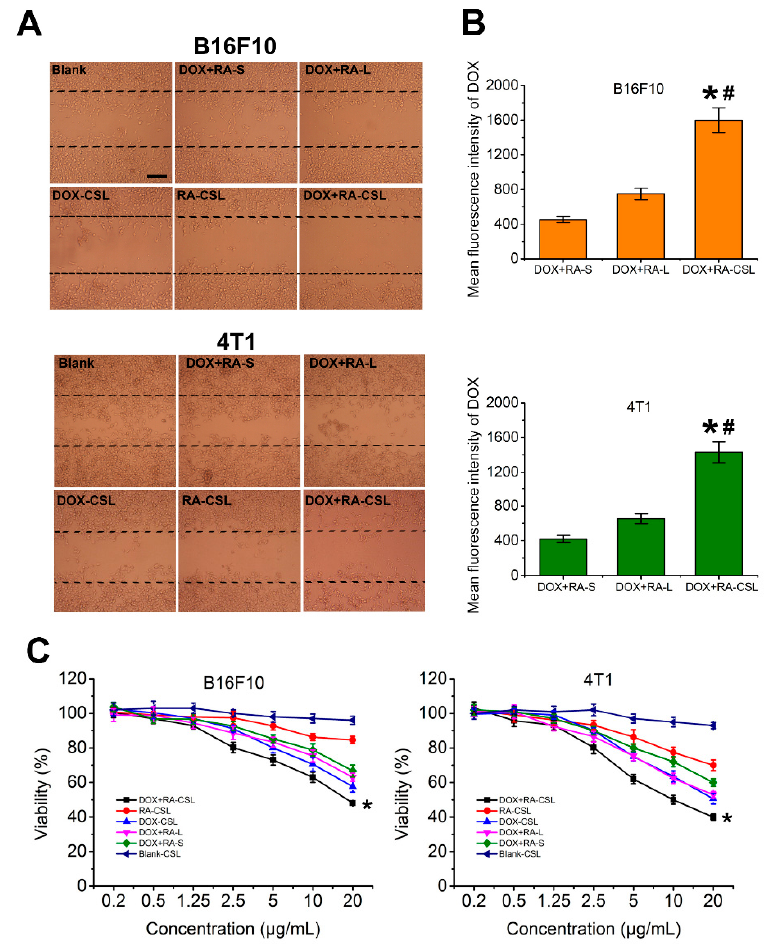
Figure 2. In vitro evaluation of DOX+RA-CSLs. ( A ) inhibition of B16F10 and 4T1 cell migration after treatment with various formulations for 24 h, Bar, 50 µ m; ( B ) mean fluorescence intensity of DOX in DOX+RA-S-, DOX+RA-L-, and DOX+RA-CSL-treated B16F10 and 4T1 cells. Data are expressed as mean ± SD ( n = 3). * p < 0.05 versus DOX+RA-S group, # p < 0.05 versus DOX+RA-L group; ( C ) cytotoxicity of drug-free and drug-loaded liposomes toward B16F10 and 4TI cancer cells after incubation for 12 h. Data are expressed as mean ± SD ( n = 3). * p < 0.05 vs. Blank CSL group. CSLs: chondroitin sulfate liposomes; RA-CSLs: retinoic acid-loaded CSLs; DOX-CSLs: doxorubicin- loaded CSLs; DOX+RA-S: DOX/RA solution; DOX+RA-Ls: liposomes co-loaded with DOX and RA; DOX+RA-CSLs: CSLs co-loaded with